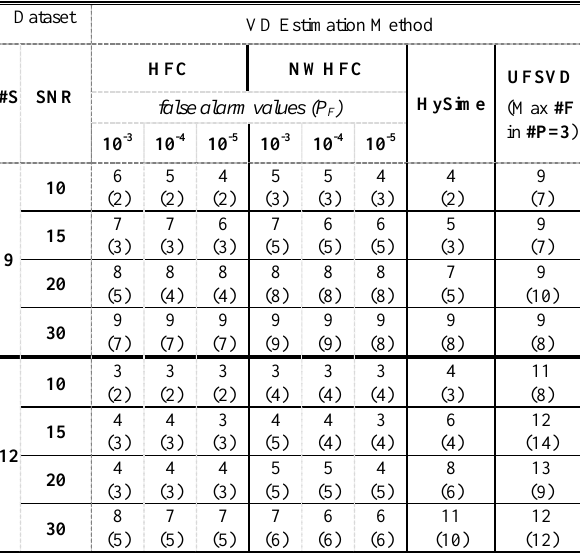
Table 3. The VDs estimated by HFC, NWHFC, HySime and UFSVD for the synthetic datasets. the results for Color-Noise- added Datasets (η=1/18; η is noise shape) are given in parentheses under those for the White-Noise-added Datasets (η=0). {{ #S : Number of Signal sources ( i.e. , Substances /Classes), #P : Number of dataset Partitions, #F : Number of selected Features.}